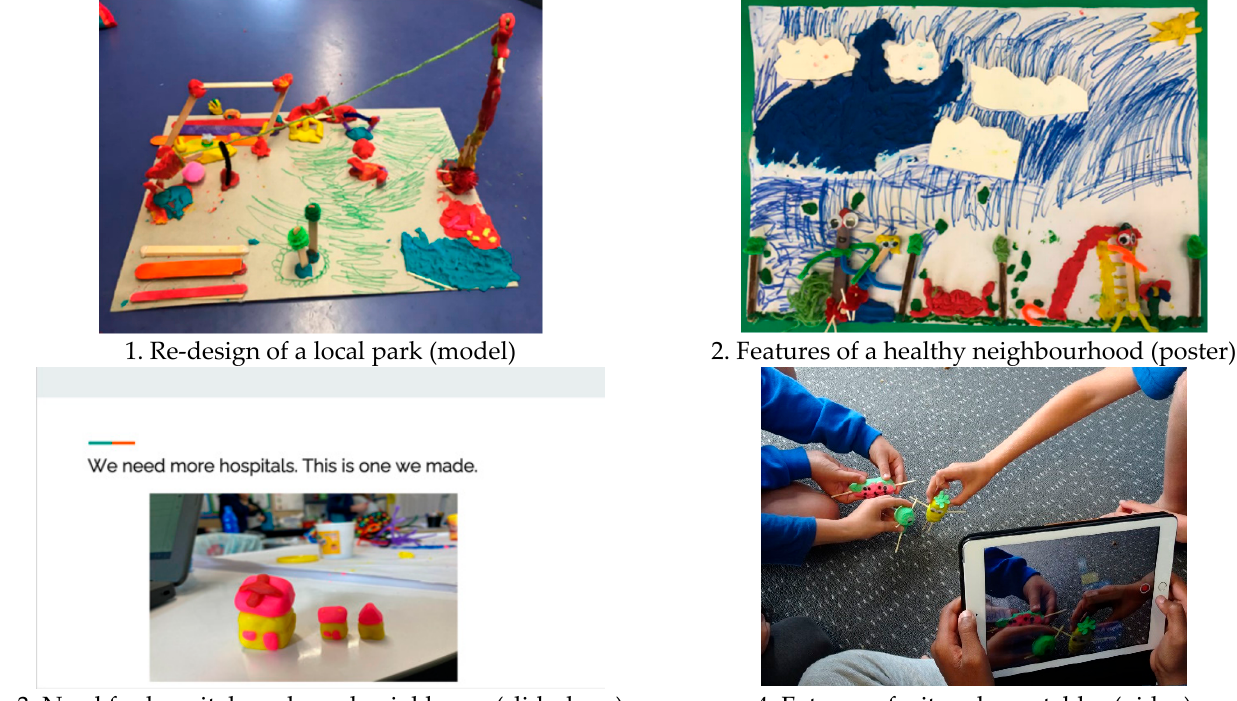
Figure 3. Examples of children’s co-created outputs in the Neighbourhoods and Health study.